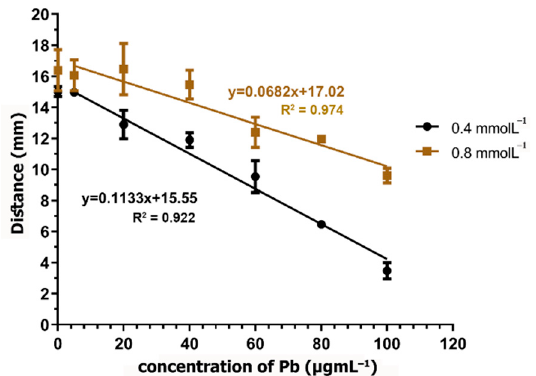
Figure 4. Color distance reduction when increasing the concentration of Pb using 0.4 and 0.8 mmol·L − 1 CA, with the Pb concentration ranging from 0 to 100 µg·mL − 1 in 0.1 M HEPES buffer (pH 7.0). Error bars represent triplicate measurements.